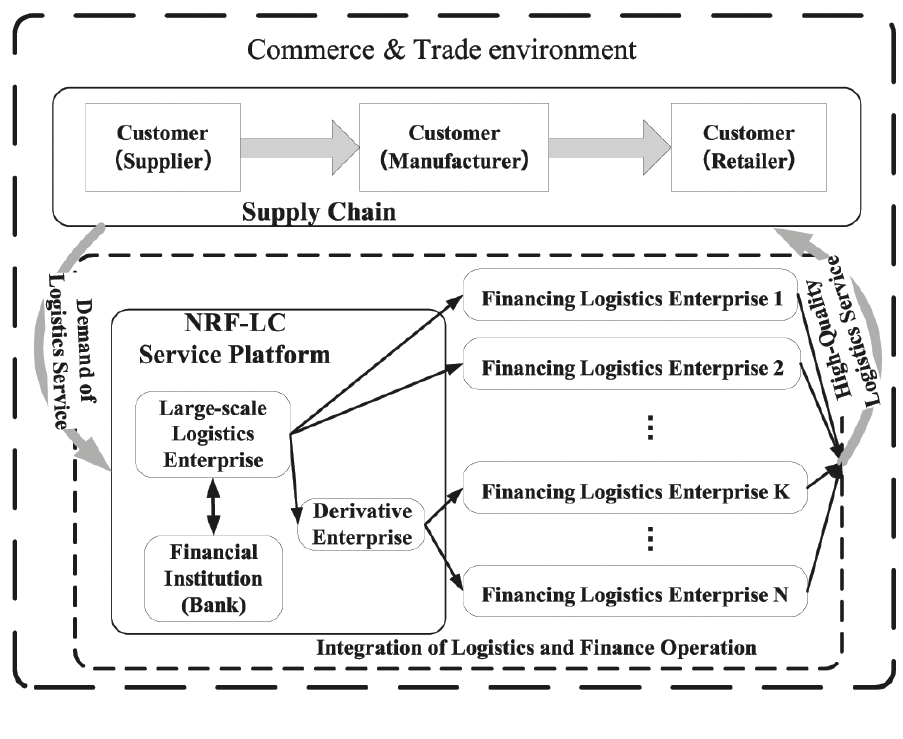
Figure 1: NRF-LC model structure